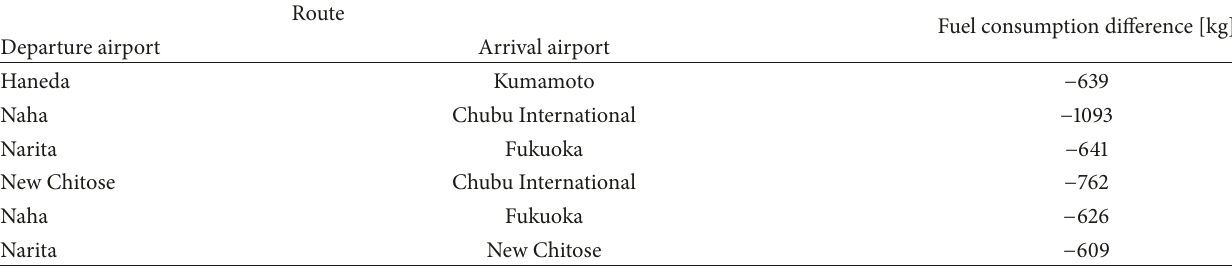
Table 7: Inefficient cases flying at the nonoptimal cruise